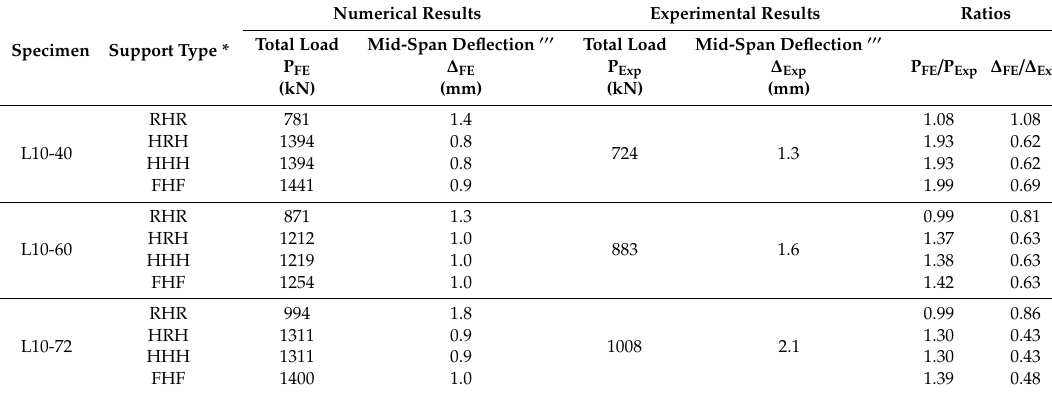
Table 3. Parametric study result